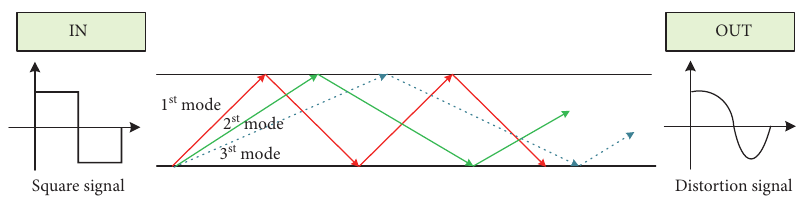
Figure 1: Signal distortion caused by the high-order mode of a transmission